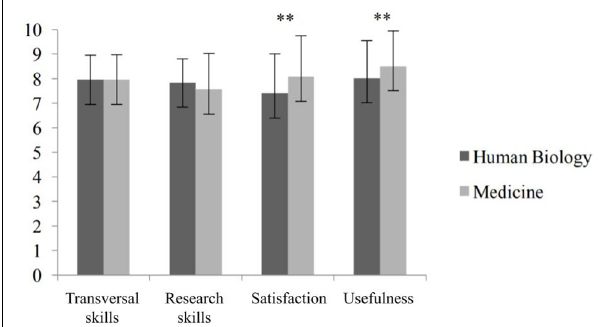
FIGURE 3 | Scores of student perceptions in the undergraduate bachelors of Human Biology ( n = 133) and Medicine ( n = 144) for the acquisition of transversal and research skills and learning experience dimensions (satisfaction and usefulness variables) in PBL-courses. Data are expressed as mean and SD. ∗∗ p < 0.01 (satisfaction, p = 0.01; usefulness, p = 0.005).